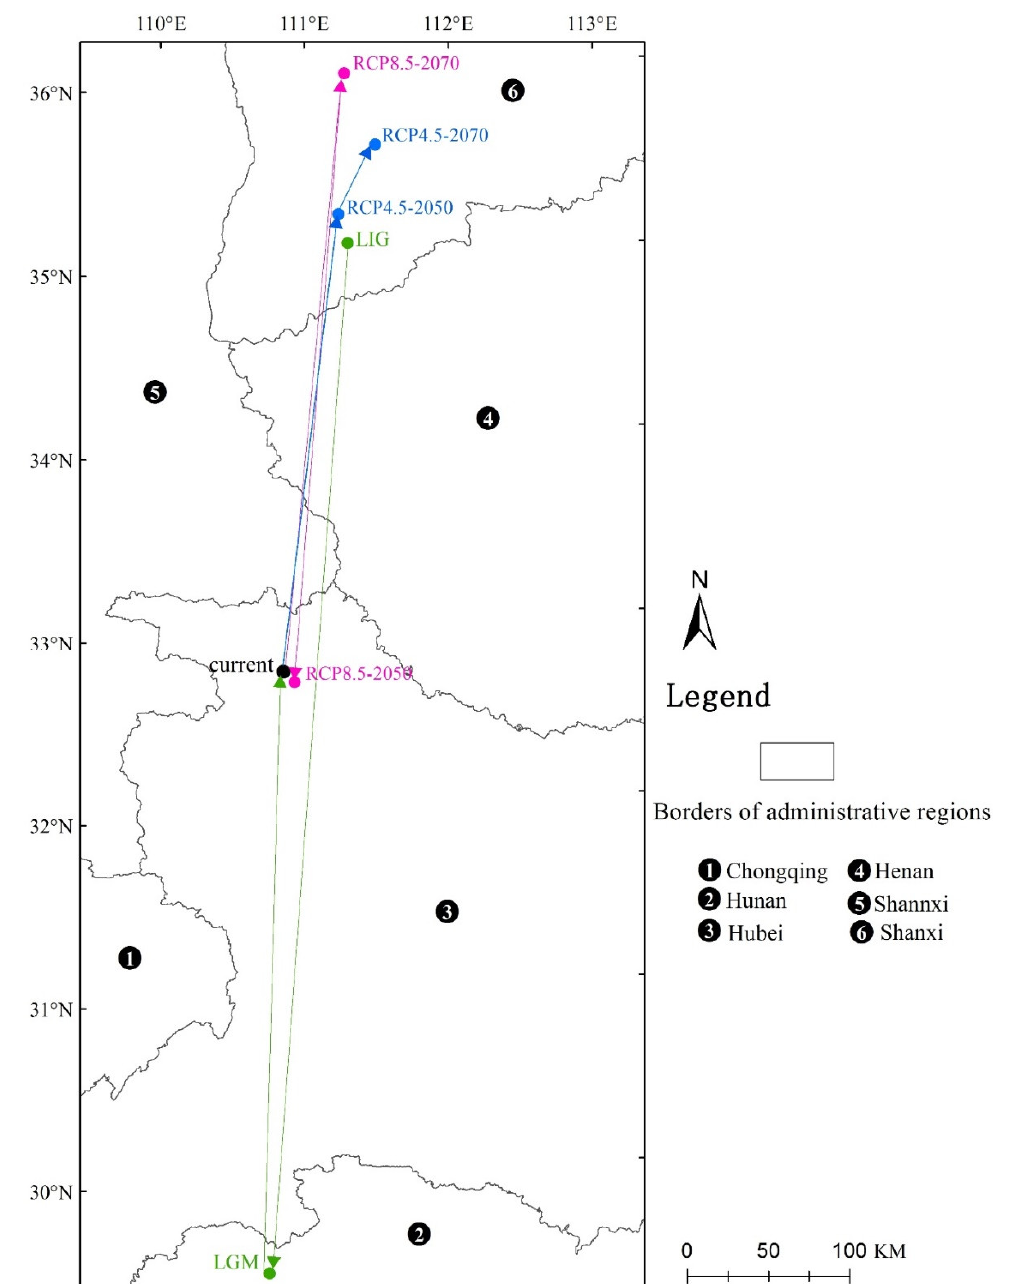
Figure 3. Core distributional shifts under different climate scenario/years for Salicaceae plants in China (Albers projection). LIG, Last Inter Glacial; LGM, Last Glacial Maximum. RCP4.5-2050, future climate scenario RCP4.5 in 2050. RCP4.5-2070, future climate scenario RCP4.5 in 2070. RCP8.5-2050, future climate scenario RCP8.5 in 2050. RCP8.5-2070, future climate scenario RCP8.5 in 2070. The green, black, purple, and blue dots respectively indicate the geometric centers of past (two glacial periods), current and future (four scenarios) suitable areas, with the arrows depicting the magnitude and direction of predicted change through time. The map was plotted using ArcGIS